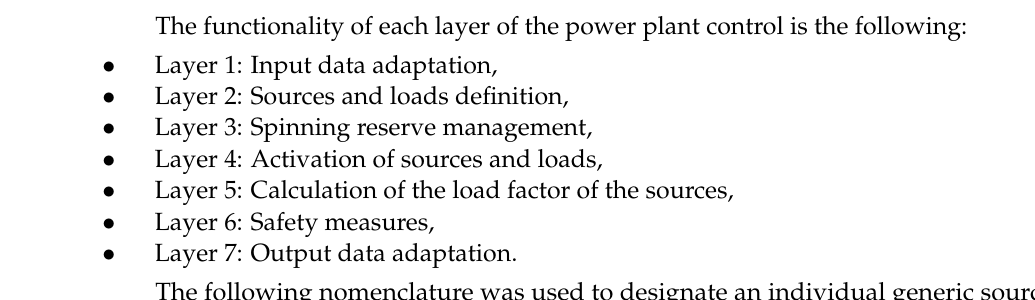
Figure 1. Global scheme of the power plant control.